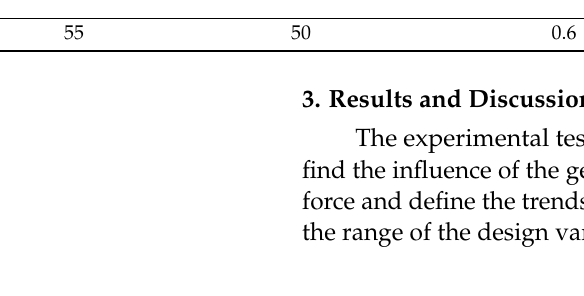
Figure 10. Parameters of the mesh used in FEM analysis. Table 2. Simulation parameters used in FEM modelling of the Table 1. Material properties used in FEM modelling of the TFL10 belt. Table 2. Simulation parameters used in FEM modelling of the punching.